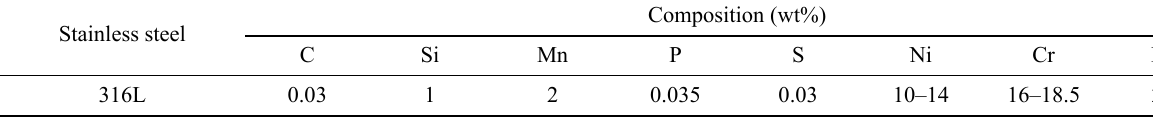
Table 2 Chemical composition of 316L and 9Cr18Mo.